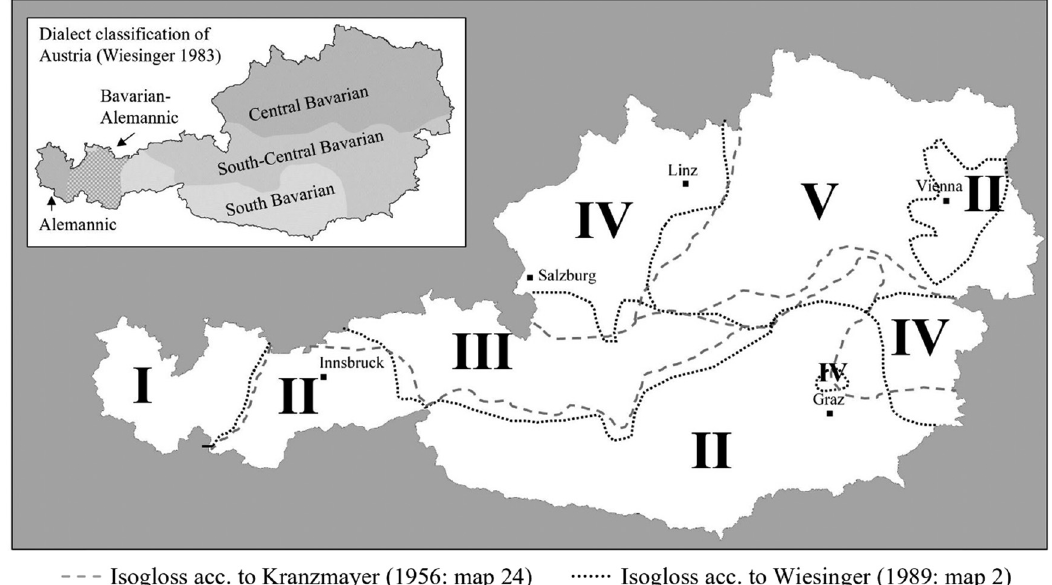
Figure 1: Core areas for variants of ( en ) in the Austria base dialects ( the roman numbers refer to core dialect areas distinguished in Table 1 )